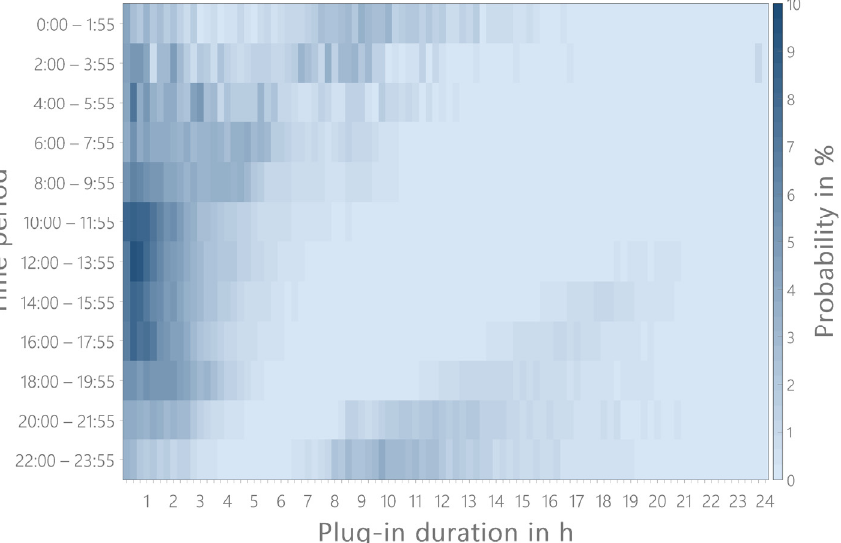
Figure 9. Heatmap of probabilities for specific plug-in duration in different time periods of the